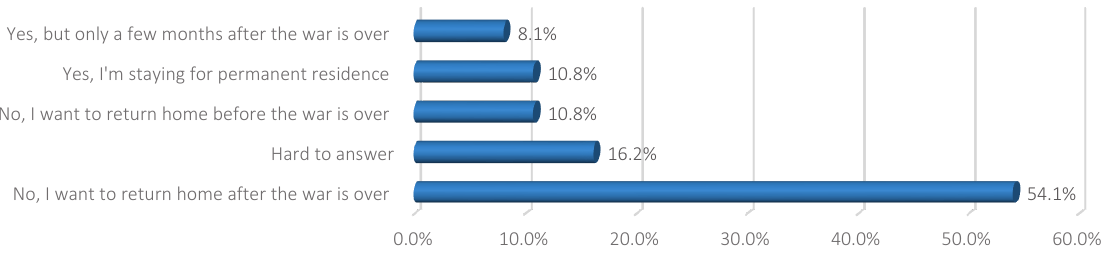
Figure 8. IDPs’ plans for further stay in the Pidberiztsivska community, % of respondents